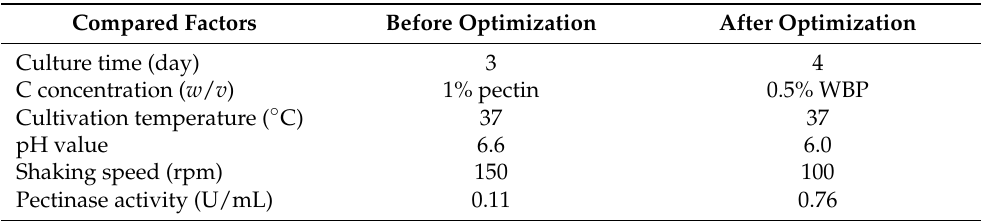
Table 1. The optimized culture conditions for the production of pectinase by B. amyloliquefaciens